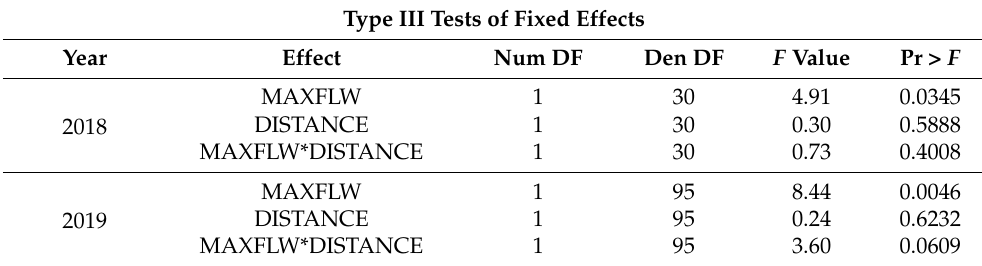
Table A21. The effect of maximum flower number and interplant distance on fertilization success at Shinob Kibe in 2018 and 2019.